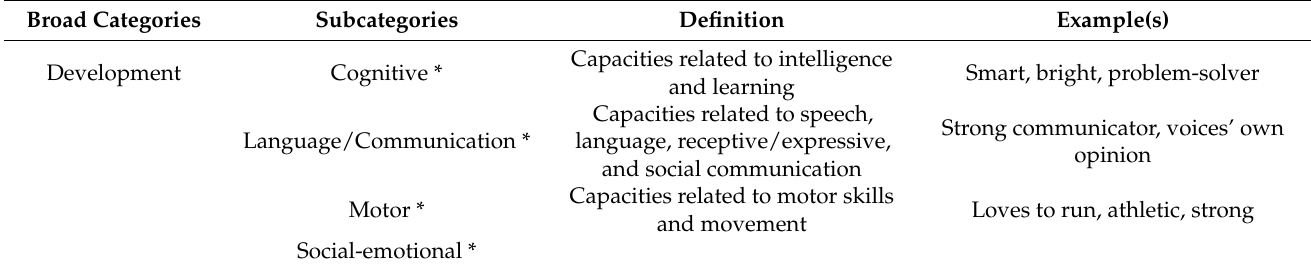
Table A2. Final Coding System Documenting 20 Unique Strengths or Best